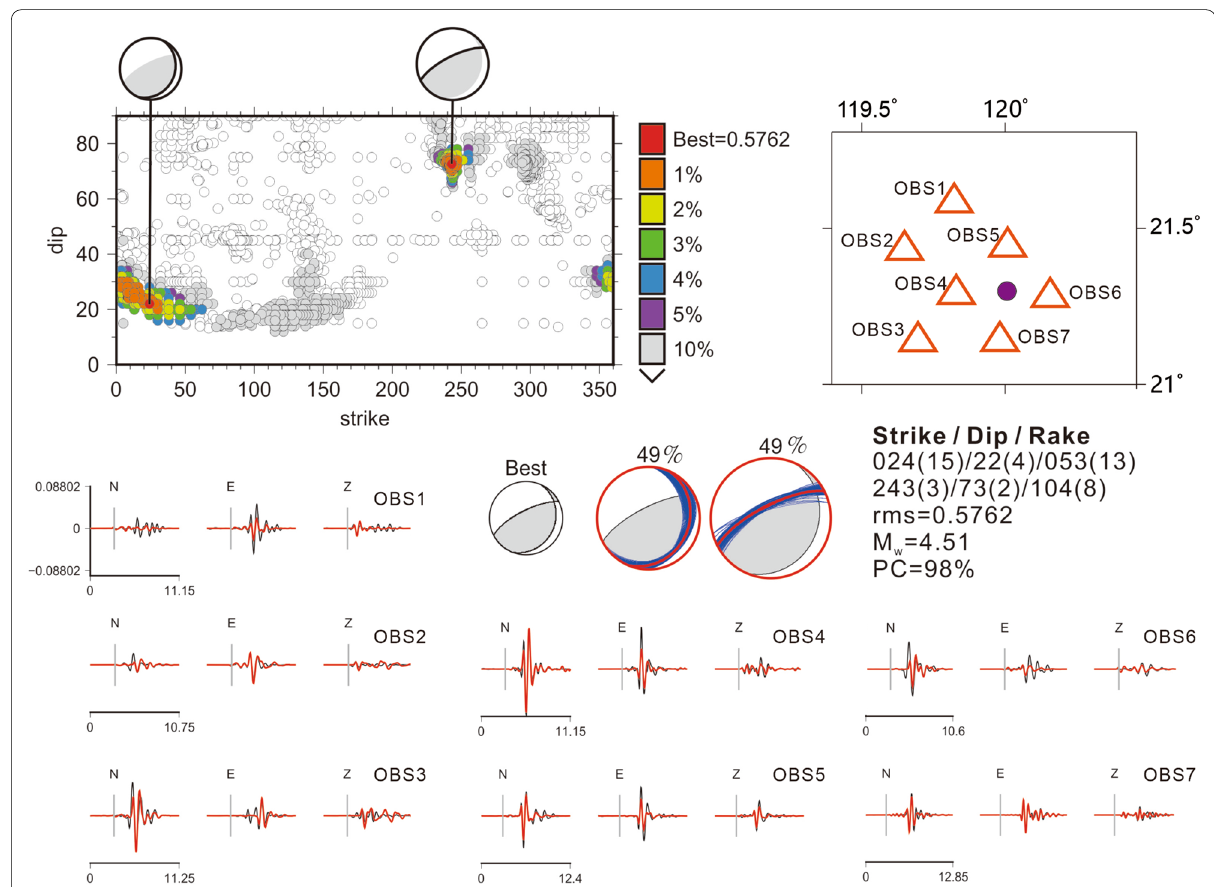
Fig. 6 Typical results obtained using the FMNEAR. In this example, the 4.51-Mw event is the main shock of the sequence